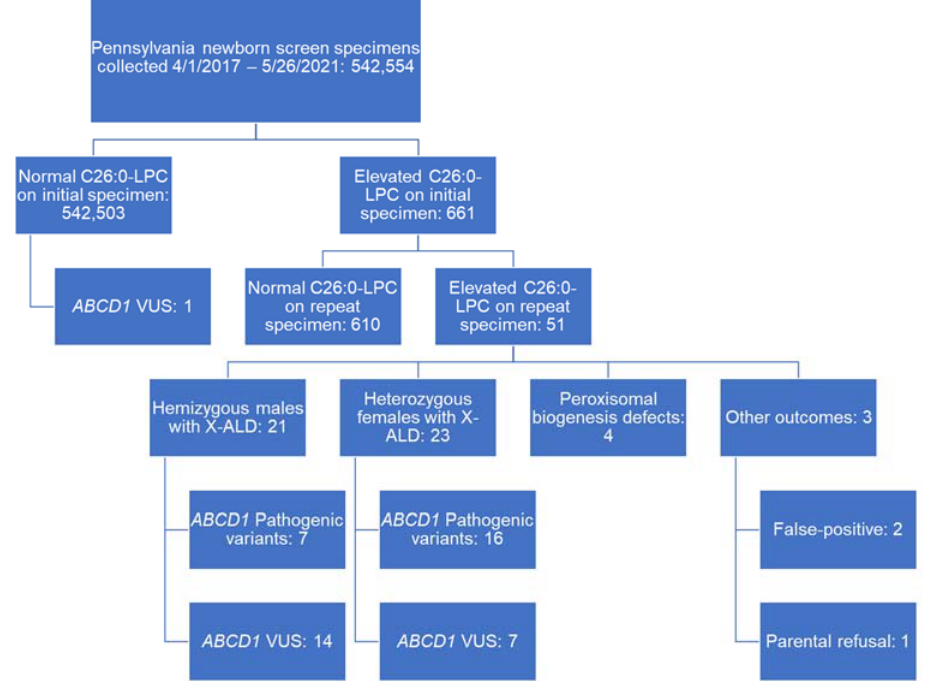
Figure 2. A visual summary of Pennsylvania X-ALD newborn screening results between 1 April 2017 and 26 May 2021. LPC = lysophosphatidylcholine; X-ALD = X-linked adrenoleukodystrophy; VUS = variant of uncertain significance. Table 1. Newborn screen, biochemical, and molecular features of 44 Pennsylvanian infants who screened positive for X-ALD between 1 April 2017 and 26 May 2021 and harbored ABCD1 variants. Screening was considered positive for second-tier LC-MS/MS quantitation of C26:0-LPC > 0.15 µmol/L on initial and repeat dried blood spot specimens. First-tier results from FIA-MS/MS are not shown. Confirmatory biochemical testing with C26:0 quantitation was performed on a clinical basis (reference range: 0.17–0.73 µmol/L). “-” denotes that the clinical information was unavailable. All units are in µmol/L. ABCD1 variants and their laboratory interpretation using ACMG criteria are listed. Variants identified in the ALD Variant Database are indicated as previously reported. Inher- itance pattern is provided for families in whom parental testing was performed and available. Fi- nally, known family history is denoted for patients in whom there were family members with con- firmed, symptomatic X-ALD phenotype. “*” indicates individuals with family members identified via NBS who are known to carry the same variant but are asymptomatic. “^” indicates family indi- viduals whose medical histories were suspicious for symptomatic individuals but for whom an X- ALD diagnosis had not been made (for example: an adult male uncle with progressive gait disturb- ance).